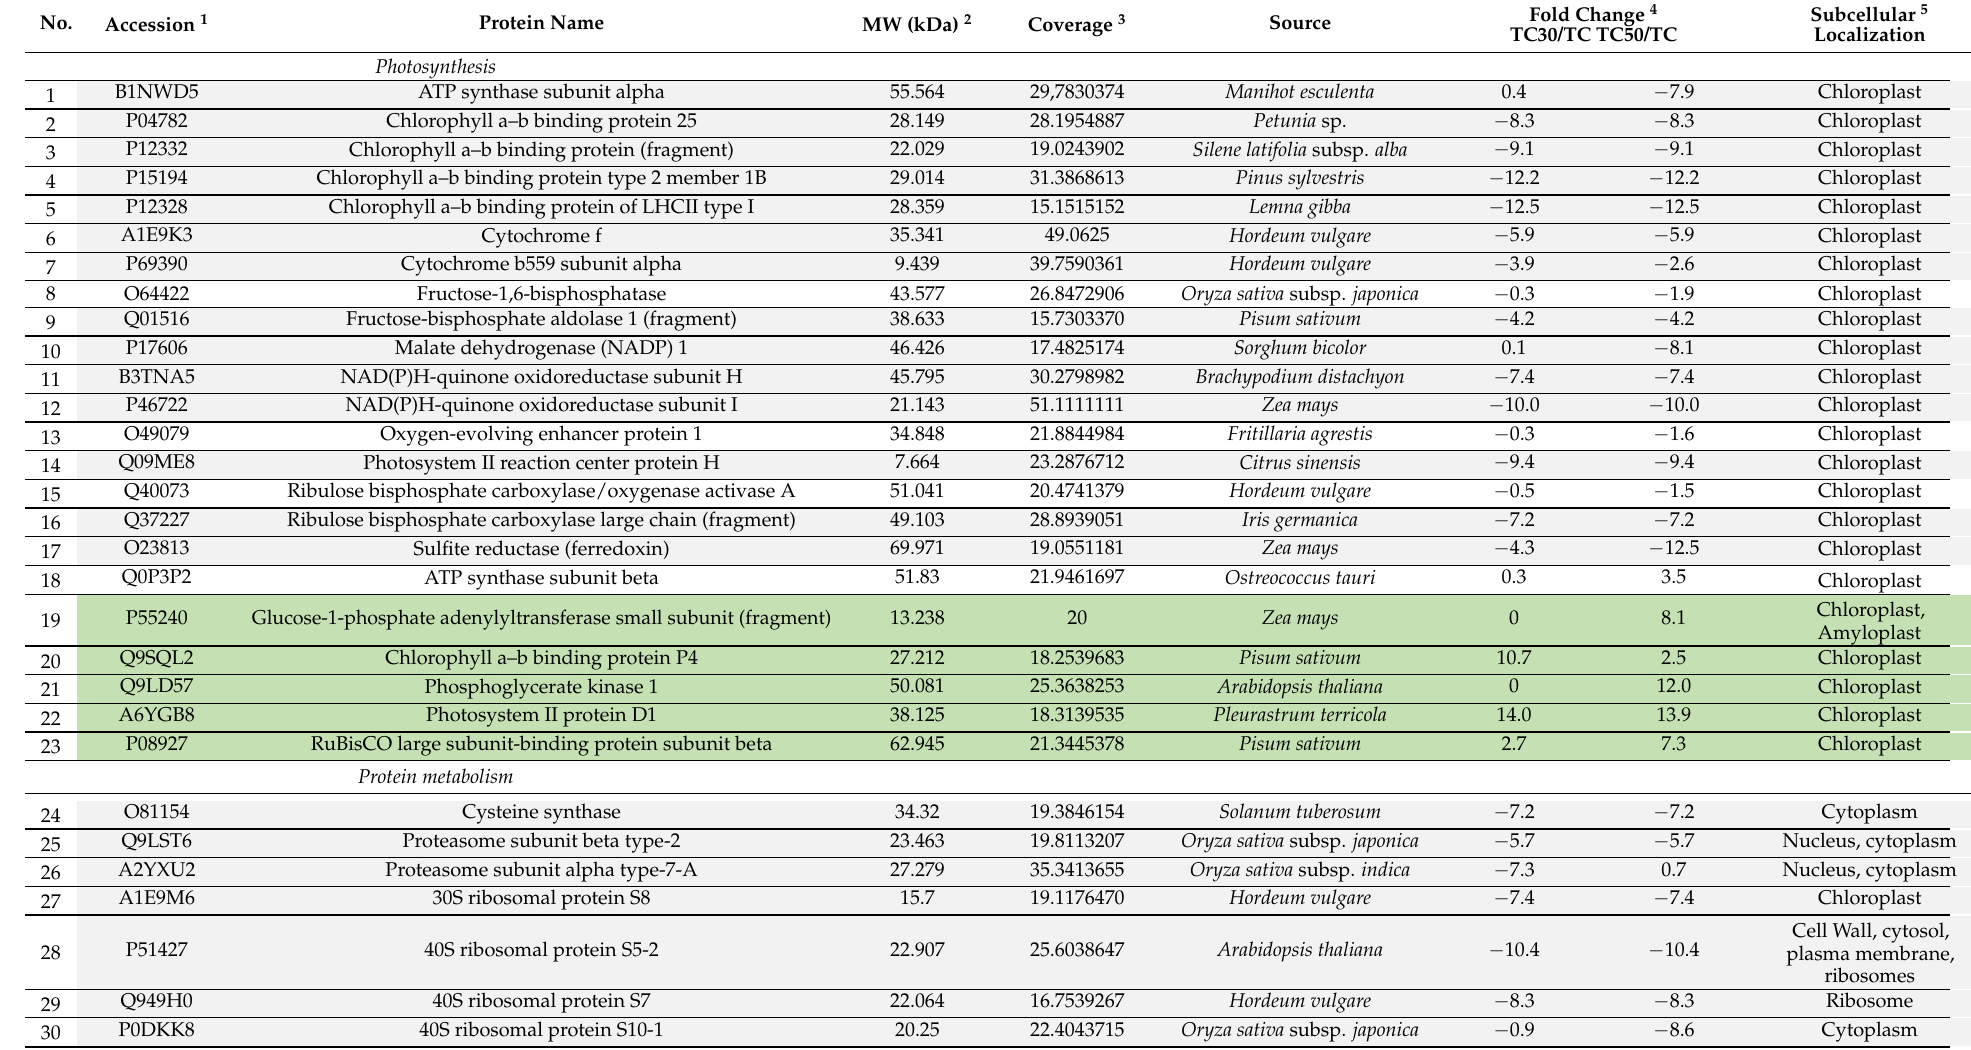
Table 2. Proteins identified in Paspalum fasciculatum leaves after 60 days of exposure to 30 and 50 mg kg − 1